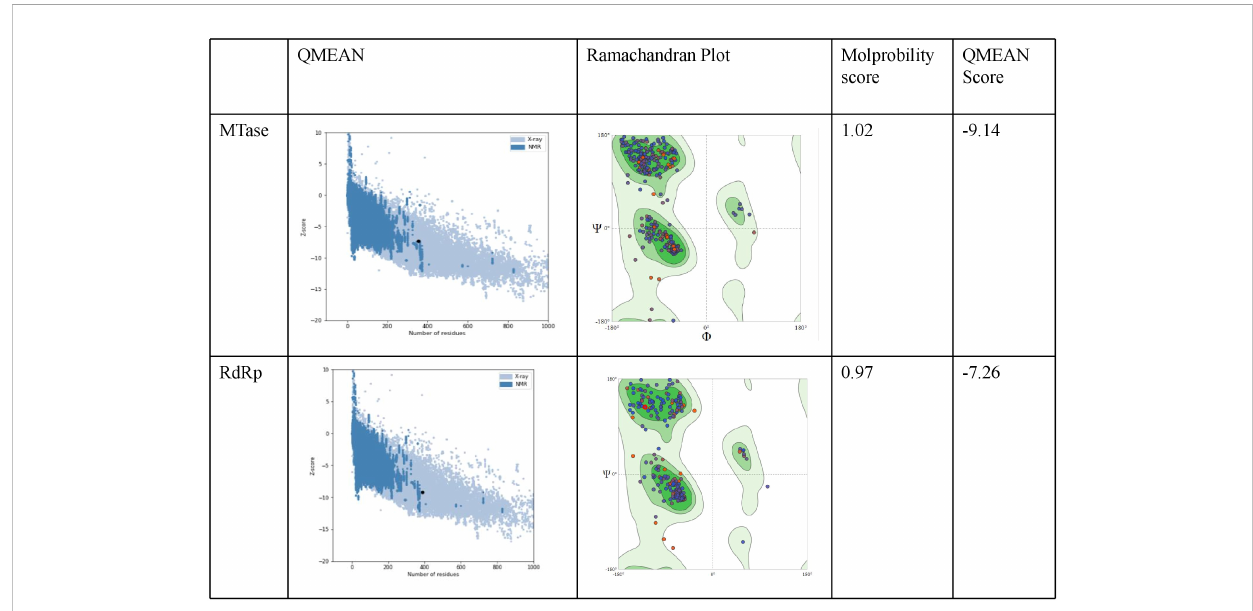
FIGURE 8 Evaluation of the modelled protein structures of CHIKV Methyl transferase (MTase) and RdRp using ProSA. As shown in the fi gure the Z-score was- 9.14 for the predicted model of NSP1 Methyltransferase domain. Ramachandran plot of NSP1 Methyltransferase domain displays most residues in the favoured regions (c). The Z - score was -7.26 for the predicted model of RdRp. Ramachandran plot analysis of NSP2 helicase domain indicates residues in the favoured, allowed and generously allowed regions with90% of residues falling into the most favoured region.